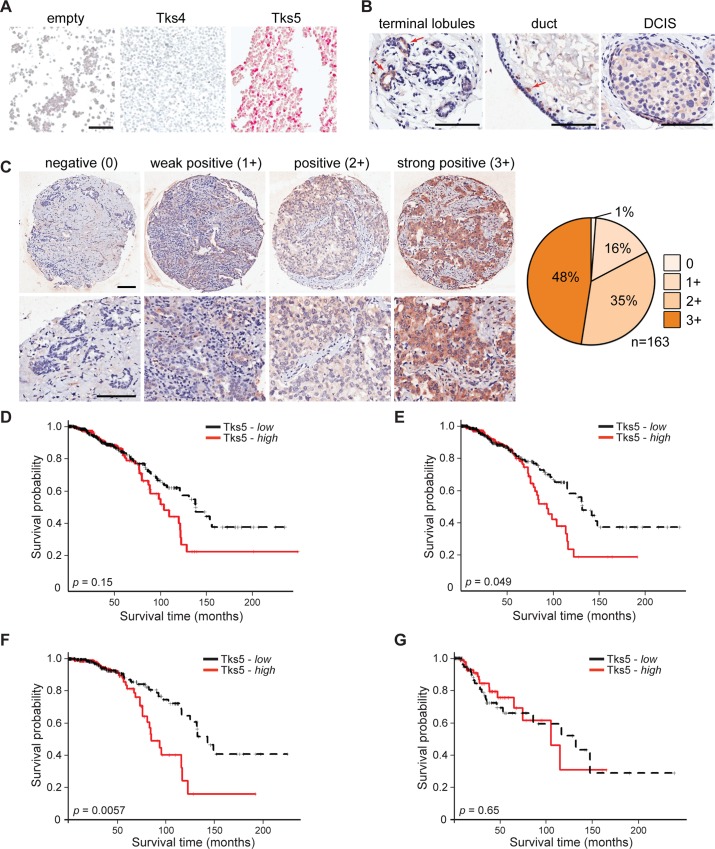
Tks5 expression in breast tissue and breast cancer.A) 293 cells were transfected with empty vector, or vectors expressing Tks4 or Tks5. Cells were pelleted, fixed, embedded in paraffin and processed for immunohistochemistry with an anti-Tks5 antibody. B) Representative images of normal breast lobules and duct, and ductal carcinoma in situ, stained with anti-Tks5 antibodies. Red arrows indicate areas with intense Tks5 staining. Scale bar represents 100μm. C) Representative images of primary invasive breast cancer specimens, at low and high magnification, to illustrate the range of Tks5 expression observed. Scale bars represent 100μm. Quantification of 163 specimens is shown on the right. D) Kaplan-Meier survival curves for patients with high (red) and low (black) Tks5α mRNA levels. E) Kaplan-Meier survival curves for stage I/II patients with high (red) and low (black) Tks5α mRNA levels. F) Kaplan-Meier survival curves for stage III/IV patients with high (red) and low (black) Tks5α mRNA levels.